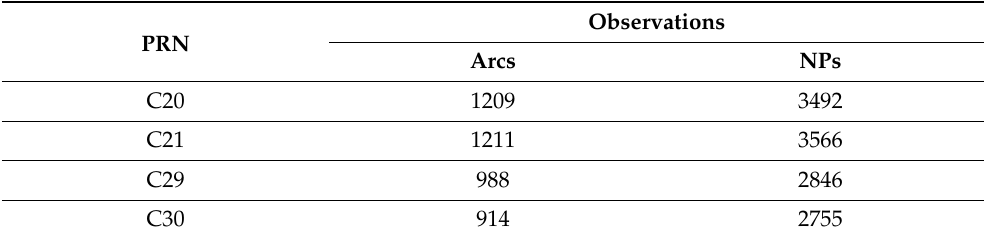
Table 3. The number of SLR observation arcs and NPs of BDS-3 satellites in 2020.